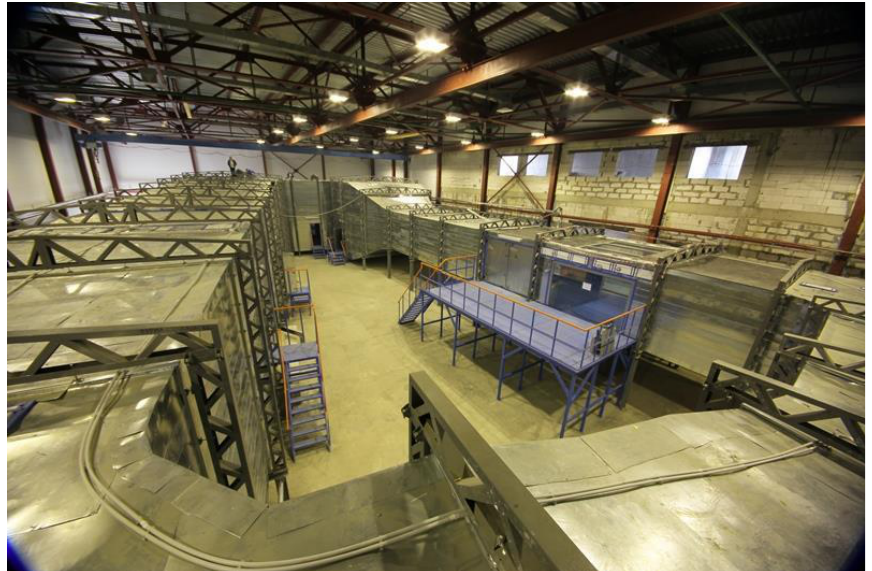
Figure 1. The wind tunnel for architectural and civil engineering purposes at MGSU.